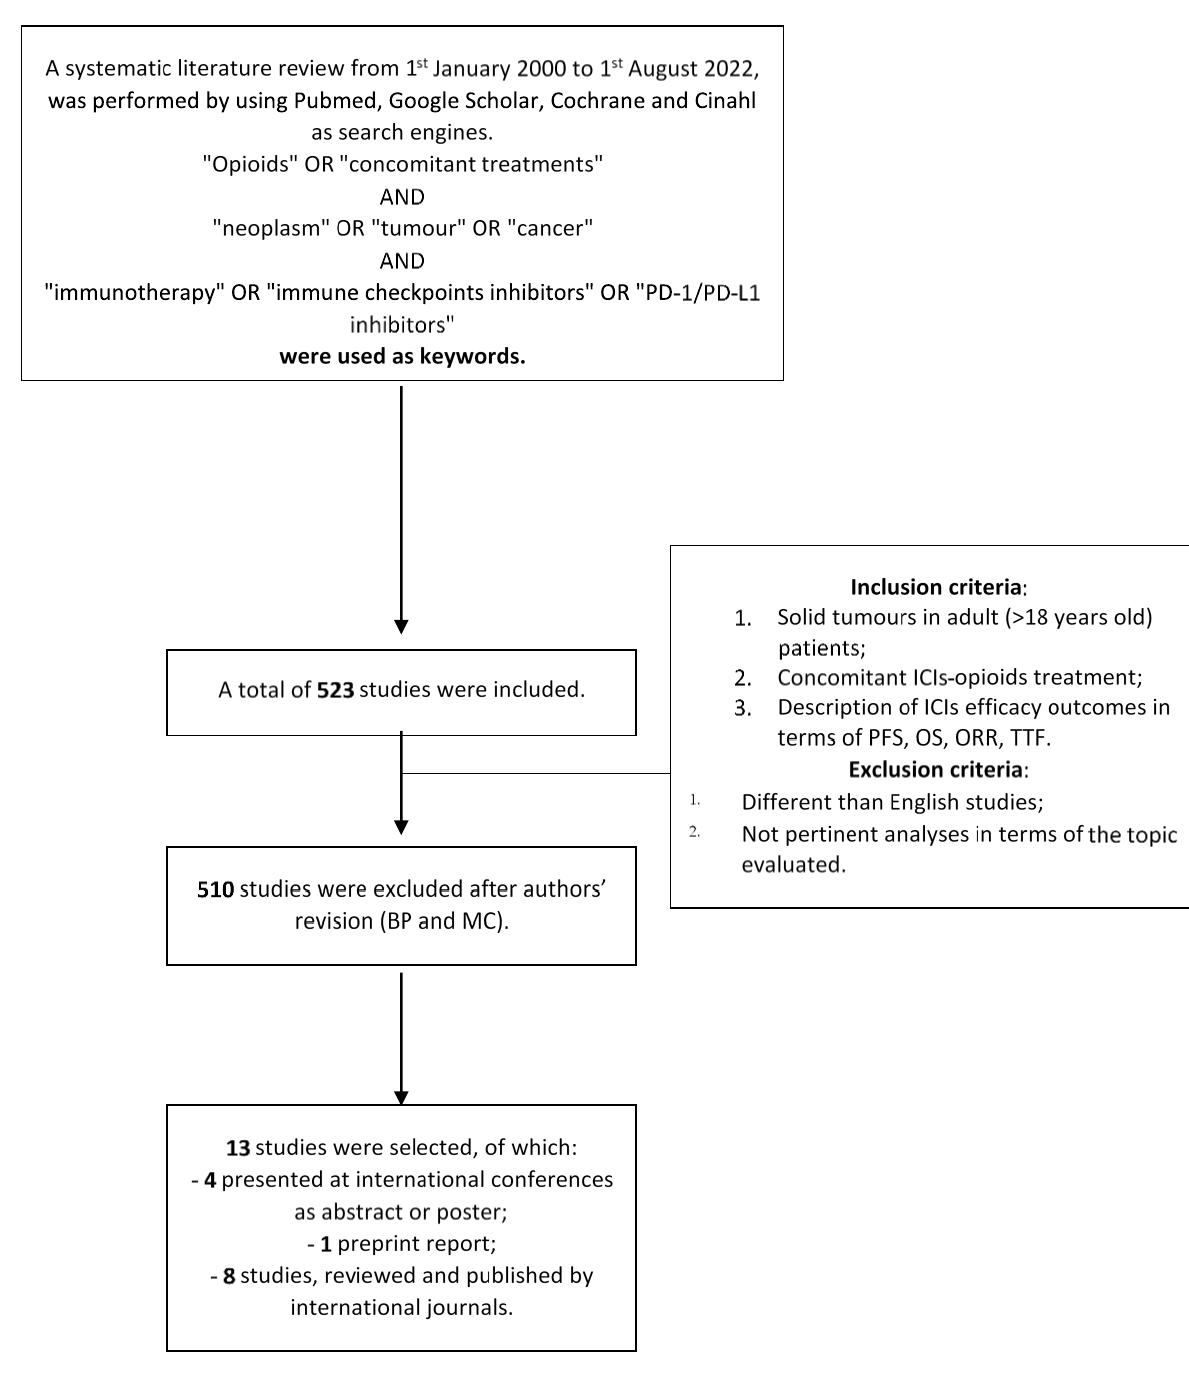
Figure 1. Brief design of the systematic review.